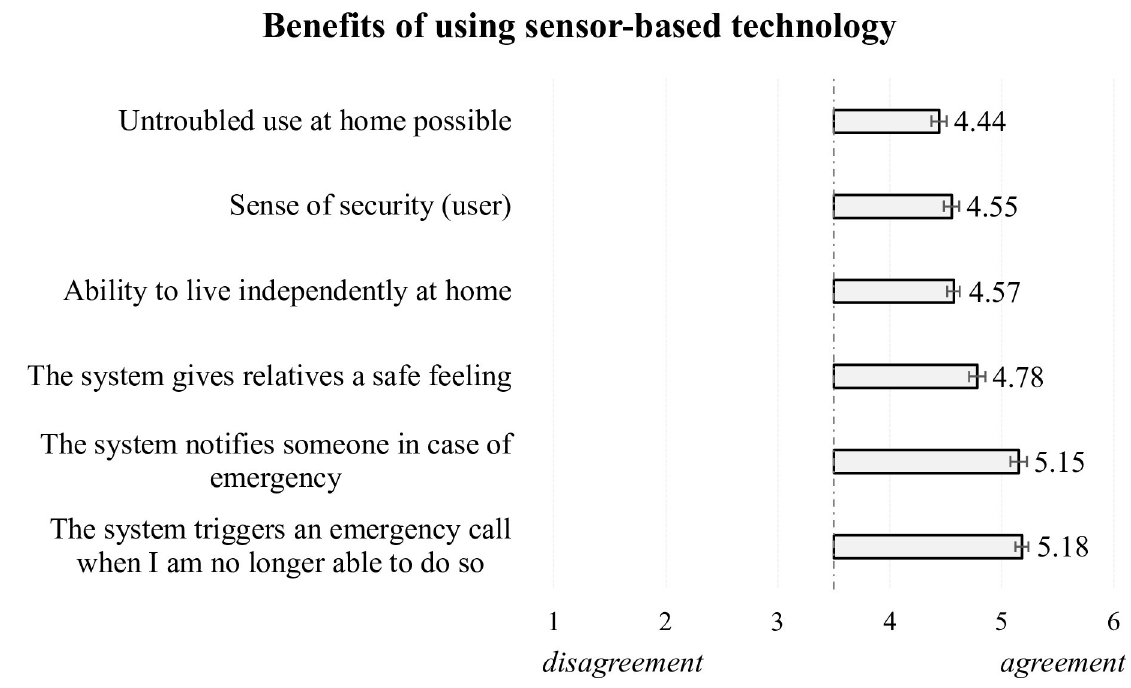
Fig 4. Perceptions of benefits when using sensor-based